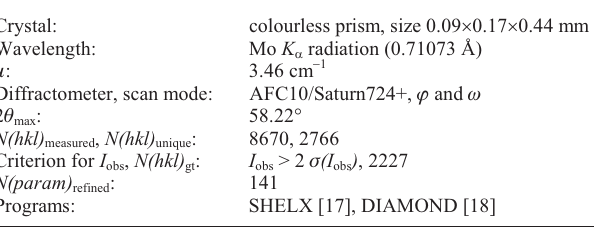
Table 1. Data collection and handling.